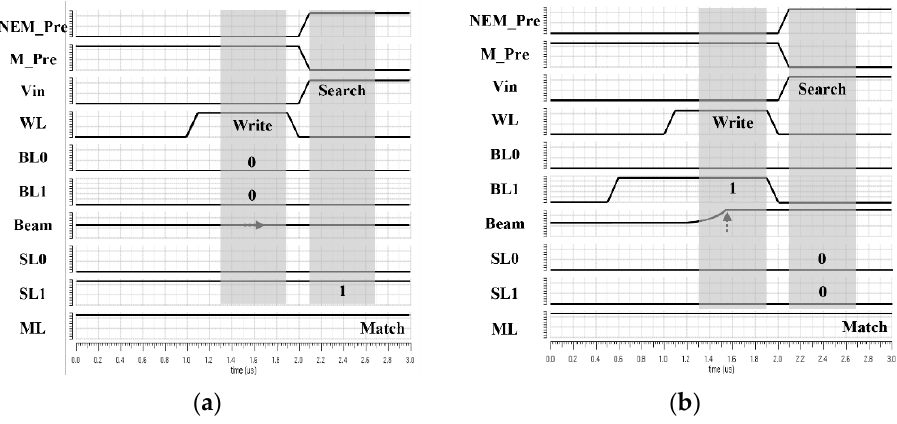
Figure 13. Pre-layout simulation of a single-bit NEM-based TCAM. ( a ) write X, search 1, ‘match’; and ( b ) write 1, search X, ‘match’. ( b ) write 1, search X, ‘match’.